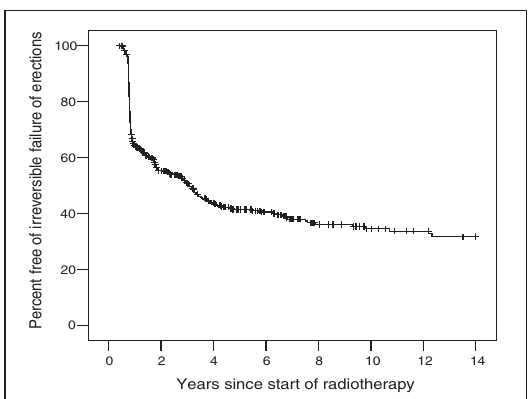
Cumulative survival free of sexual grade 3 toxicity (complete loss of erections)